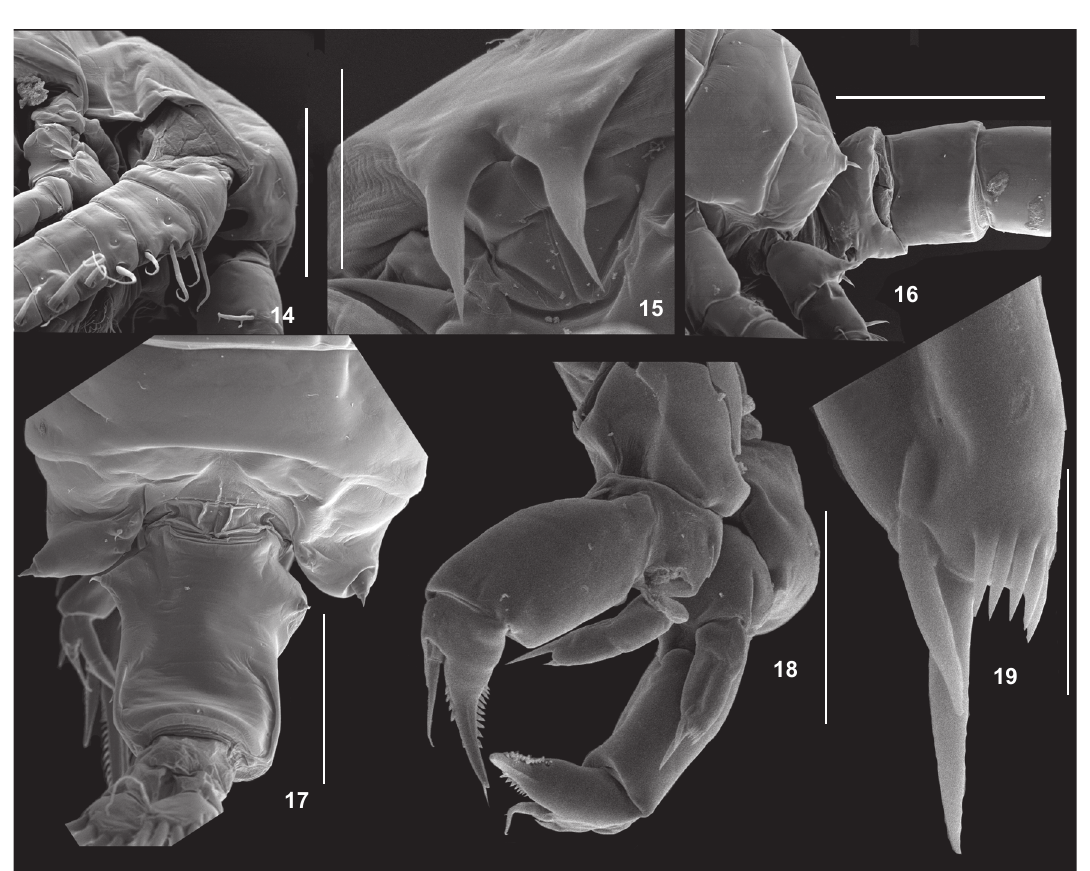
Figure 14-19. Argyrodiaptomus bergi adults, scanning electron microscope (SEM) photomicrographs: (14) rostrum, proximal segments of right (geniculate) antennule of male; (15) rostrum; (16) genital somite of male, lateral view; (17) posterior prosomites and urosome of female, dorsal view; (18) leg 5 of female, frontal oblique view; (19) detail of leg 5 endopod of female. Scale bars: 14 = 200 µm, 15 = 50 µm, 16 = 300 µm, 17 = 500 µm, 18 = 100 µm, 19 = 20